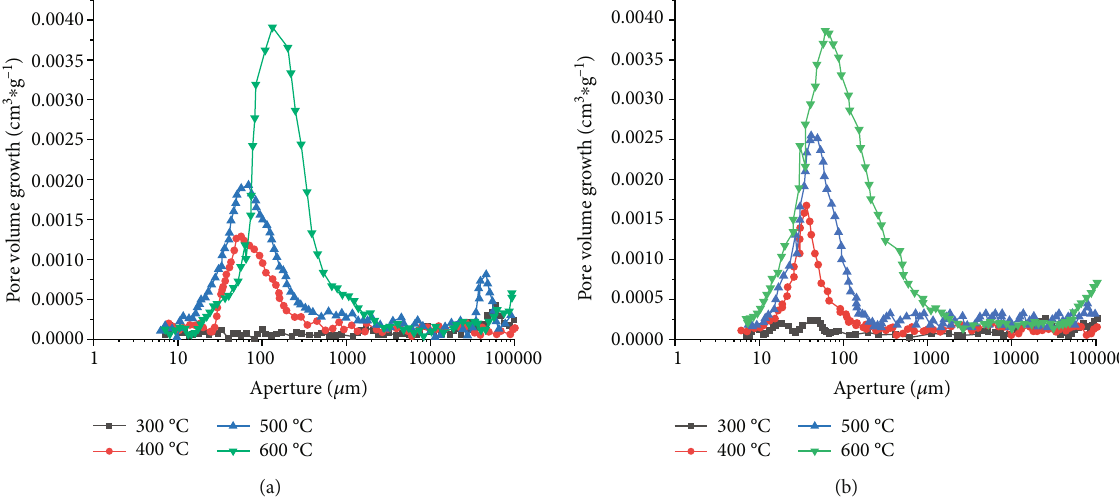
Figure 15: (a) Curve of the distribution of pore size of sample No. I. (b) Curve of the distribution of pore size of sample No.